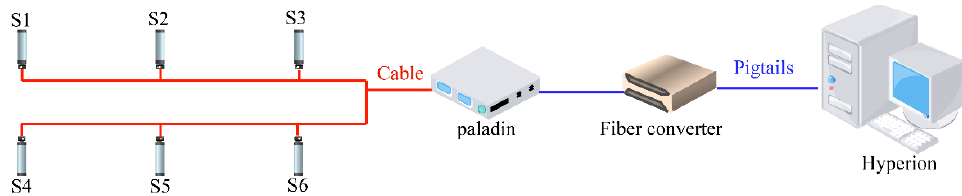
Figure 4. Spatial topology of the MS monitoring system for the spillway tunnel project.